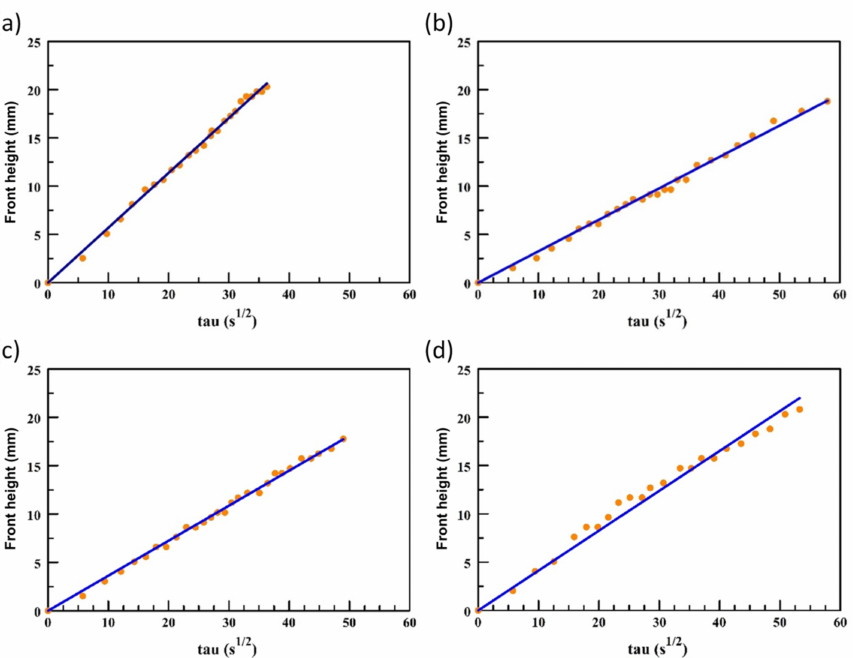
Figure 6. Height of the wetting front in uncoated and coated Lecce stone specimens for absorption through the untreated face vs. the square root of time of water absorption. ( a ) Uncoated (APL16); ( b ) FSC2-PFPEsol coating (APL1); ( c ) FSC2-PFPEsusp coating (APL2); ( d ) N215 coating (APL6). The blue straight line represents the fit by Equation (4); tau is the square root of the acquisition